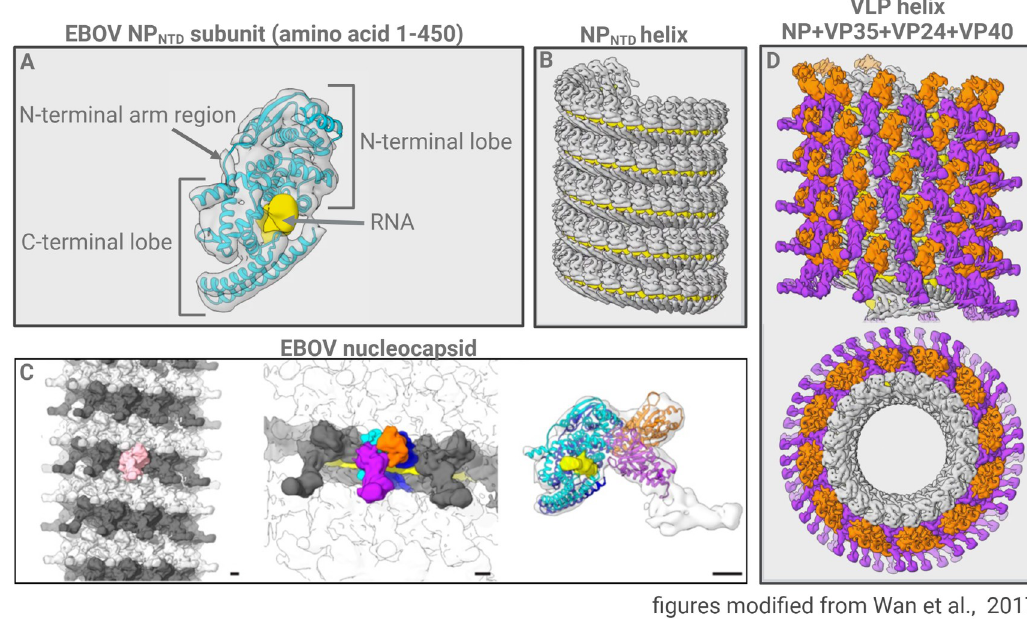
Fig 2. Structure of Ebola virus nucleocapsids [15]. ( A ) NP NTD monomer (amino acid 1–450) derived from subtomogram averaging of NP NTD helices (see B) with the aligned crystal structure in cyan and the putative RNA binding site in yellow. An arrow indicates the N-terminal arm region with the N-terminal helix. ( B ) The left-handed NP NTD helix bound to an RNA chain (yellow). ( C ) Model of the EBOV NC derived from Cryo-ET and subtomogram averaging. Left: NC structure of EBOV. Subunits of 1 rung are shown in dark or light gray. One subunit is highlighted in pink. Middle: The NP NTD subunits are highlighted in cyan and blue, the structures highlighted in orange, and purple are NP CTD protrusions, 2 VP24 molecules and VP35. The bound RNA is highlighted in yellow. Right: side view of the asymmetric protomer showing 2 molecules of NP NTD (cyan and blue), 2 molecules of VP24 (orange and purple), and unassigned densities most likely corresponding to NP CTD and VP35 (light gray). ( D ) Structure of recombinant EBOV NC obtained from virus-like particles composed of NP, VP35, VP24, and VP40. Top: longitudinal presentation of the helix; bottom: cross-section of the helix. The boomerang-shaped protrusions are highlighted in purple, and small protrusions are highlighted in orange. The inner layer composed of NP NTD is shown in gray. Figures are modified from Wan and colleagues [15]. Figure was created with BioRender.com. Cryo-ET, cryo-electron tomography; NC,